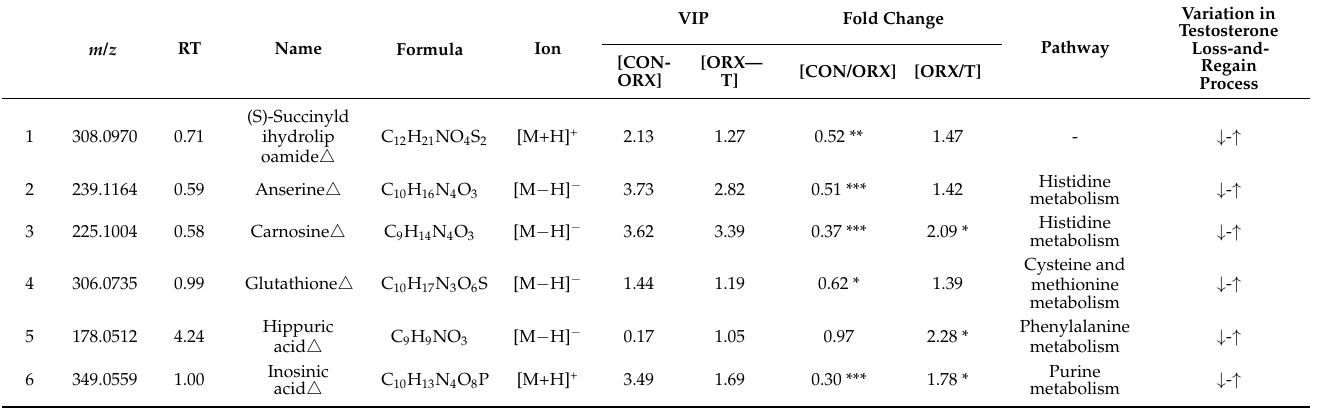
Figure 3. The clustering heatmap of Sham, ORX, and T group based on the 31 differential metabolites in skeletal muscle. Metabolites are divided into three groups according to the vary trend via androgen loss-and-regain process. Class1: Sham group; Class 2: ORX group; Class 3: T group. Table 1. Differential metabolites related to muscle–bone crosstalk and therapeutical effects of testosterone throughout the androgen loss-and-regain process.